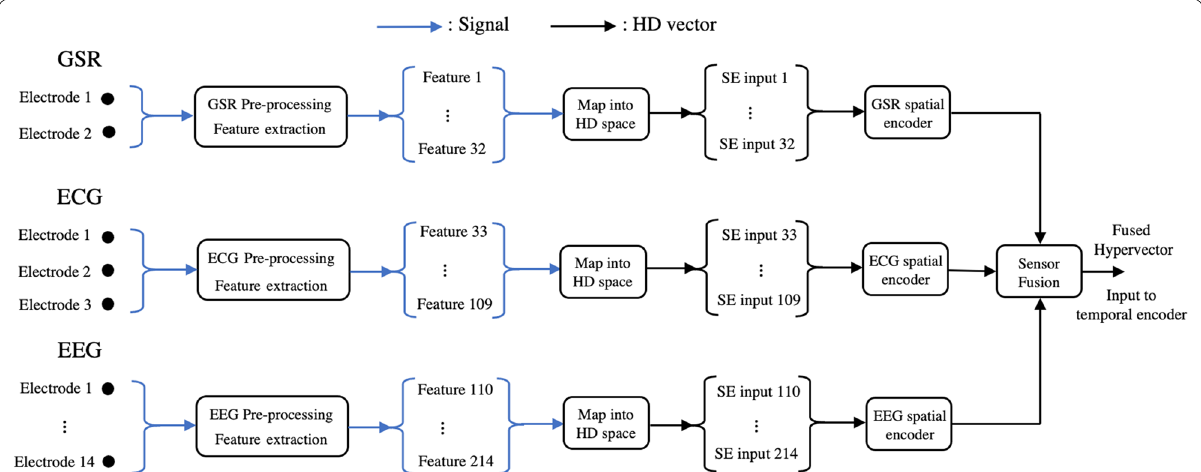
Fig. 1 Sensor fusion datapath from electrodes to a fused hypervector for the three-modality emotion recognition system used in AMIGOS with GSR, ECG, and EEG sensor inputs. The sensor inputs are pre-processed into a set of features which are then mapped into the HD space to create a set of spatial encoder (SE) inputs. These vectors are encoded within each modality, and then finally fused together to create one vector representing information from all of the channels. The process is detailed in Sect.